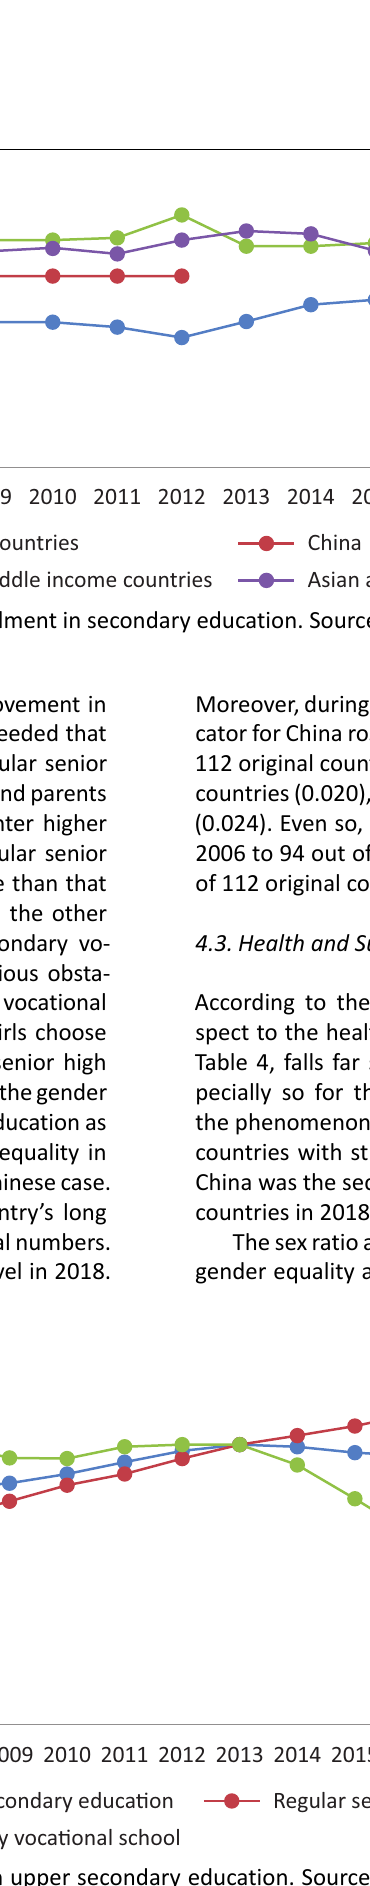
Figure 6. Female percentage of enrollment in upper secondary education. Source: Ministry of Education of the